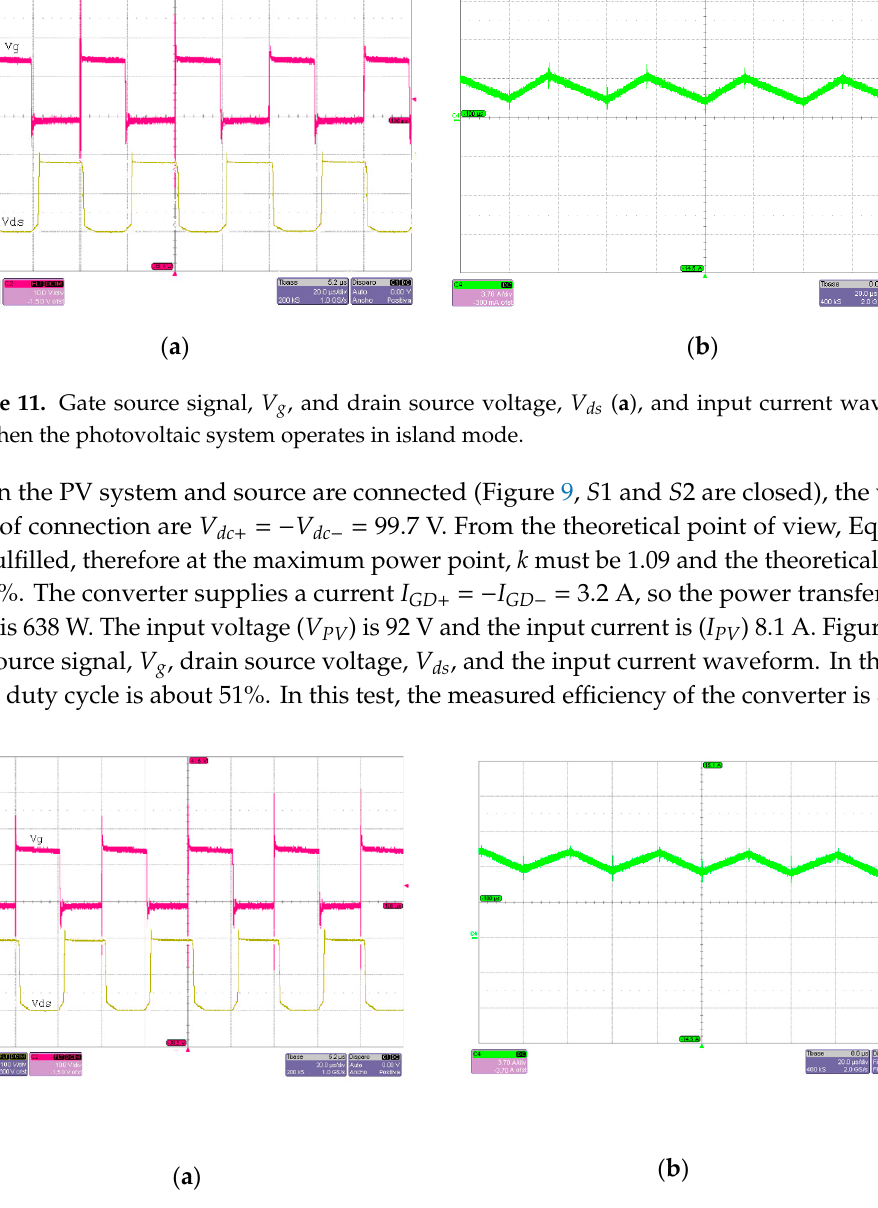
Figure 12. Gate source signal, V g , and drain source voltage, V ds ( a ), and input current waveform ( b ) when the photovoltaic system operates in parallel with a bipolar DC source.